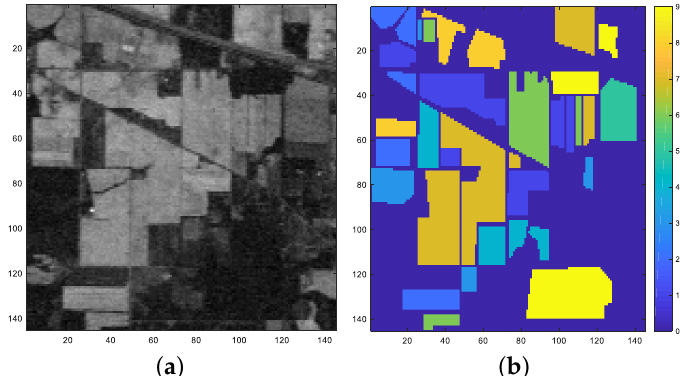
Figure 3. Band 170 and the ground truth of the Indian Pine dataset. ( a ) Band 170. ( b ) The ground truth map (label 0 denotes